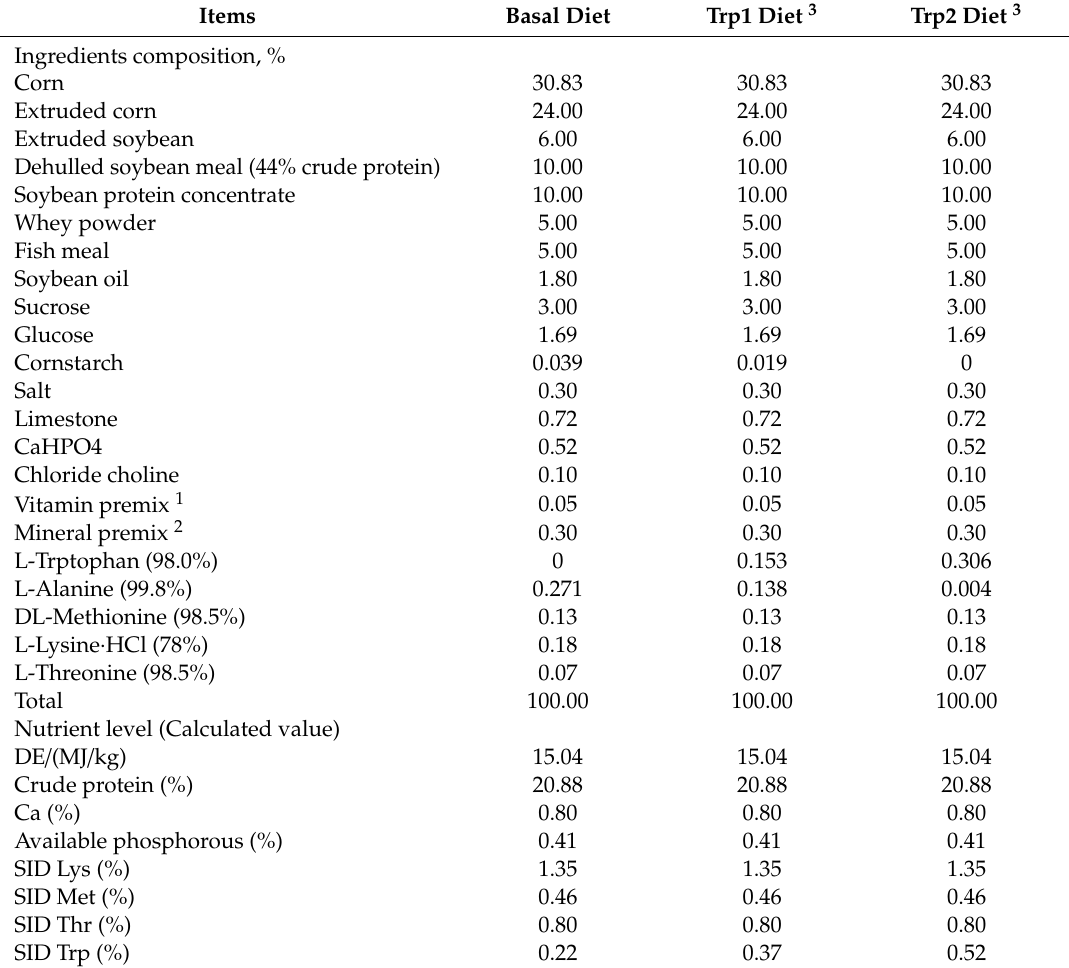
Table 1. Ingredients and chemical composition of experimental